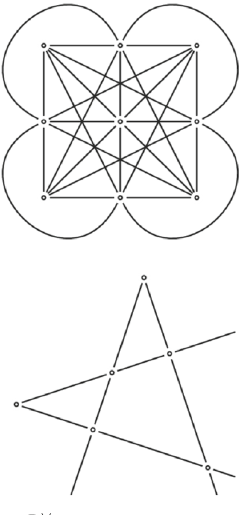
Fig. 2 The affine plane P 3 and the dual affine plane P ∨